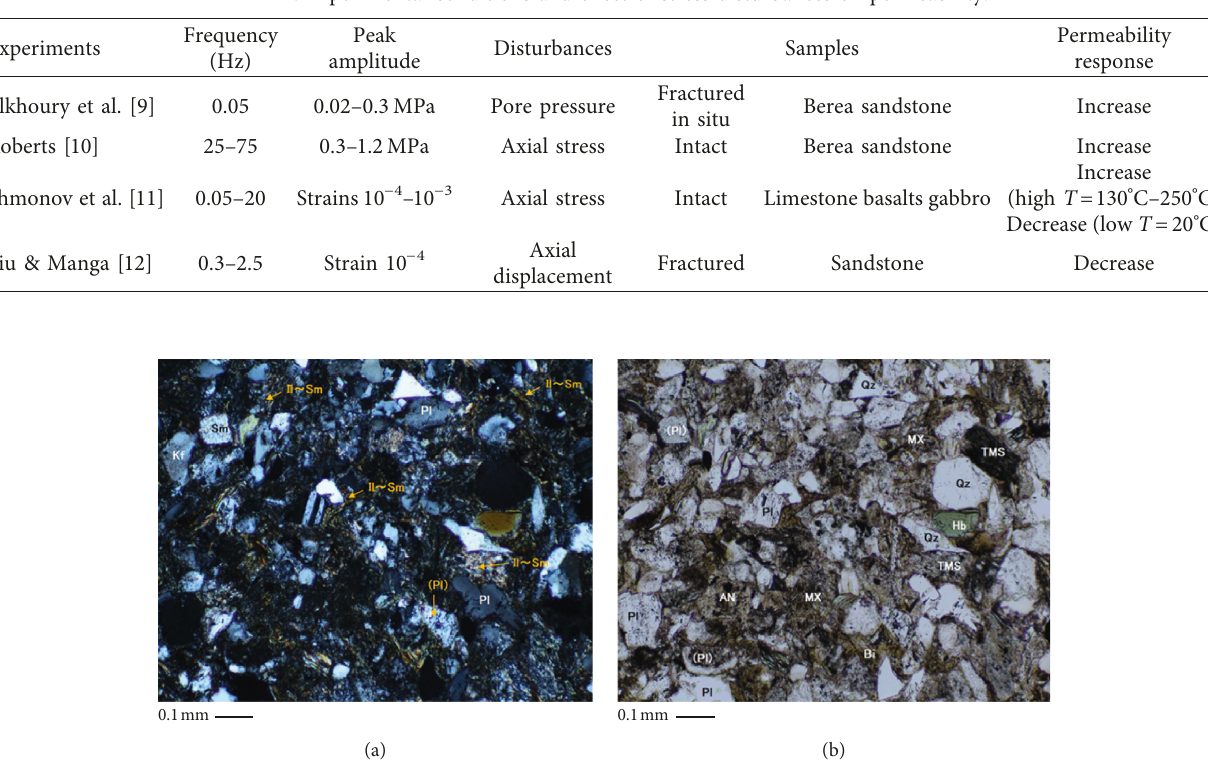
Table 1: Experimental conditions and effect of stress disturbances on permeability.